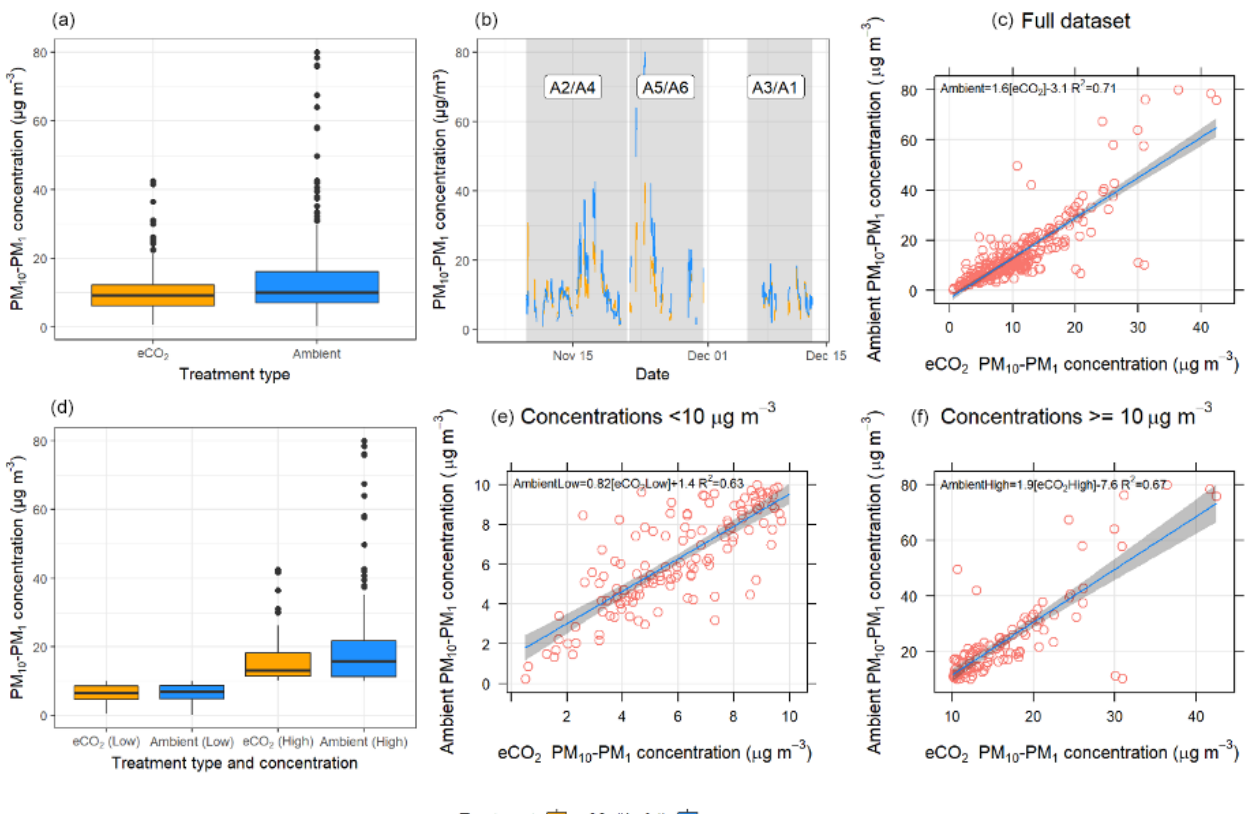
Figure 7. Bioaerosol concentrations across the experimental duration in ambient (arrays 2, 3, and 5) and e CO 2 (arrays 1, 4, and 6) arrays. e CO 2 treatment is shown in orange; ambient control is in blue. Panels (a) , (b) , and (c) include the full dataset, with no significant difference shown between the e CO 2 treatment and control. Panels (d) , (e) , and (f) split the dataset into low ( < 10µgm − 3 ) and high ( > = 10µgm − 3 ) bioaerosol concentrations. When the data are split in this way, there was no significant difference between treatments under low bioaerosol concentrations. However, when bioaerosol concentrations were high, concentrations were significantly lower under e CO 2